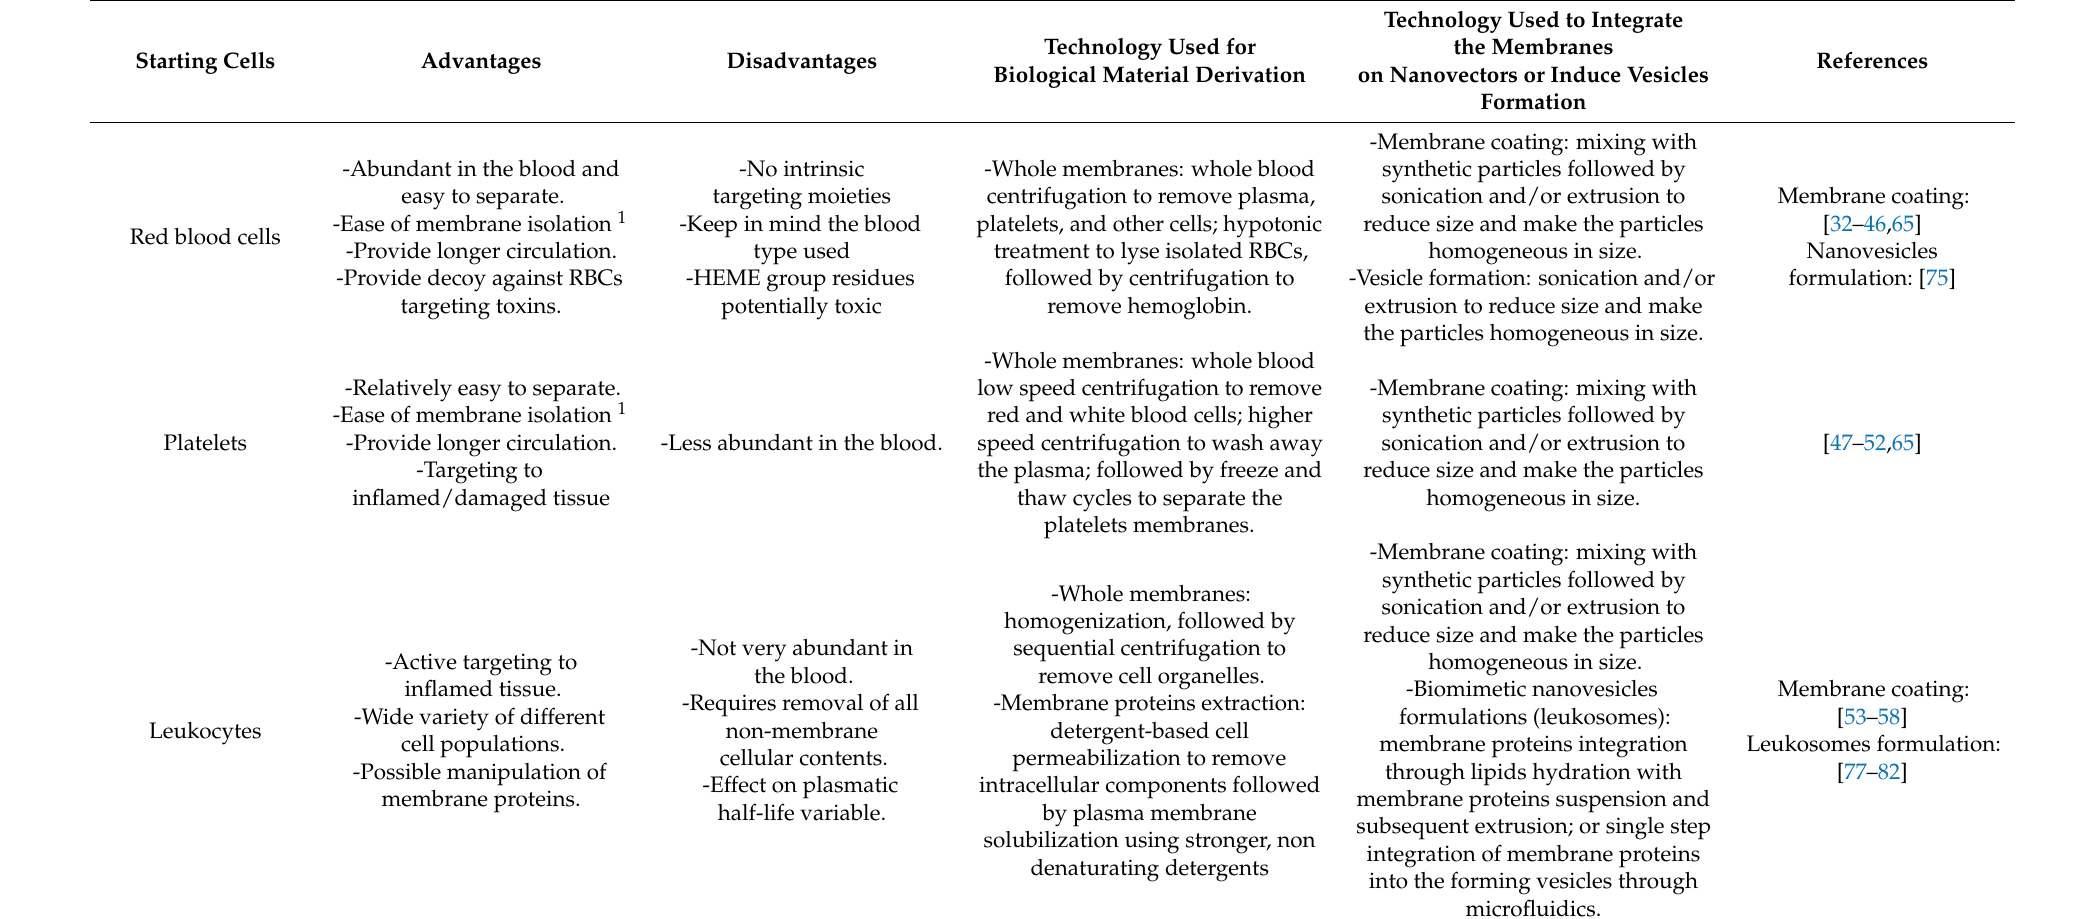
Table 1. Summary of the different advantages and disadvantages for each cell line used for biomimetics formulation, as well as the techniques used for membrane and membrane components isolation and integration in